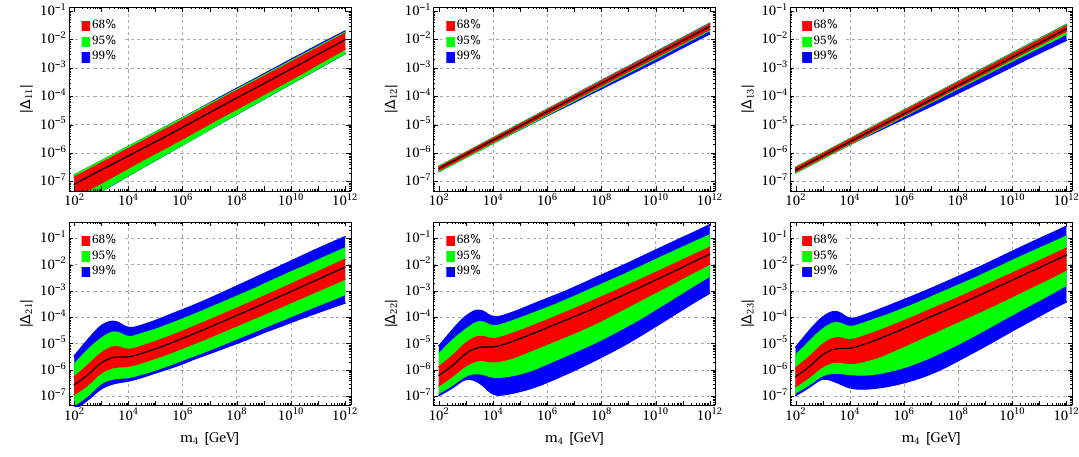
Figure 6 . (Color online) The modulus of the values of the Yukawa couplings (cid:1) 1 and (cid:1) 2 as functions of M R (cid:24) m 4 for the (cid:12)xed value of (cid:21) D = 1 for the normal hierarchy. For each value of m 4 we show over 32.000 points that come from varying the phase (cid:30) 0 for each of the 1.000 points in the Higgs sector, like in (cid:12)gure 2. The black line marks the median of these 32.000 values for each value of m 4 . The 68% of values of j (cid:1) jk j closest to the median are shown in red, the values in the range of 68% to 95% are shown in green, and the values in the range of 95% to 99% are shown in blue. We do not show the values outside the range of 99%, as they would (cid:12)ll up the rest of the plot and no information could be obtained by looking at it.